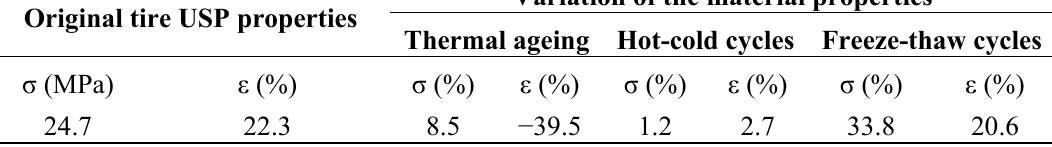
Table 5. Variation of tire USP properties after climatic processes.